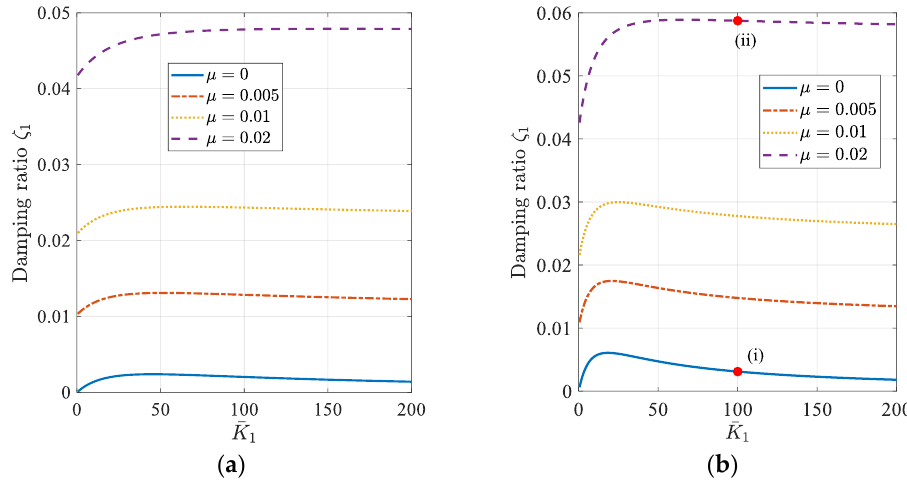
Figure 5. First modal damping of a cable with two dampers versus the HDR damper stiffness 𝐾̅ 1 ( 𝜑 = 0.5,𝜌 = 1, 𝑥 2 /𝐿 = 0.5), with ( a ) 𝑥 1 /𝐿 = 0.02 and ( b ) 𝑥 1 /𝐿 = 0.05.